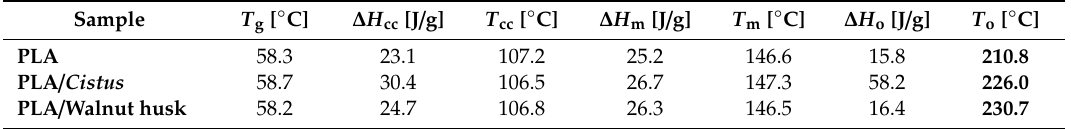
Table 3. Di ff erential scanning calorimetry (DSC) analysis of PLA samples impregnated with extracts of Cistus and walnut